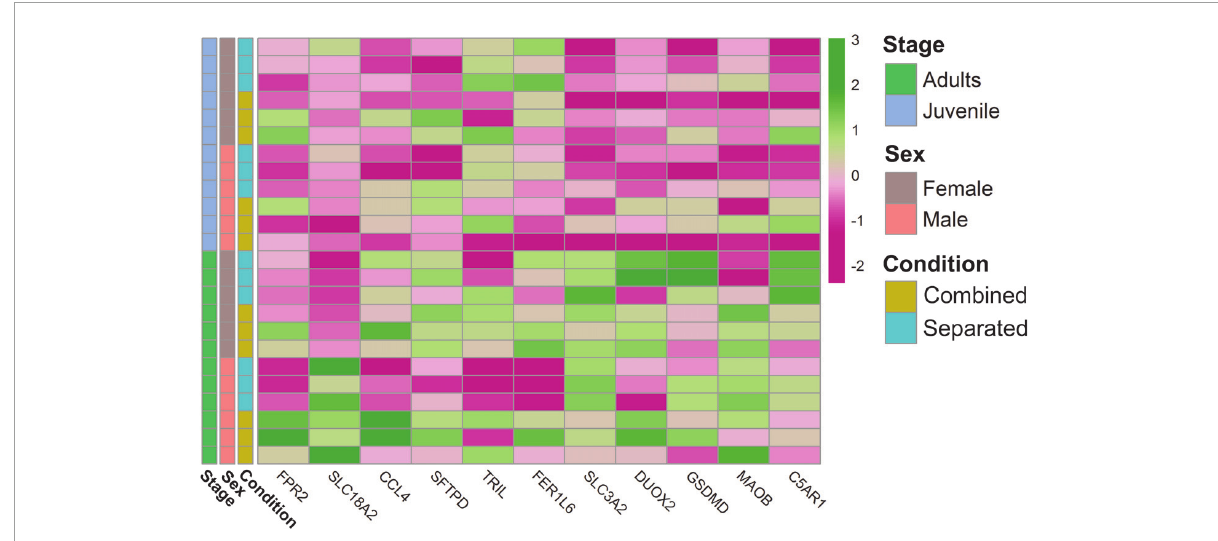
FIGURE5 Heatmap of genes related to the VNO capability of detecting external stimuli, harmful pathogens and its relation with the immune